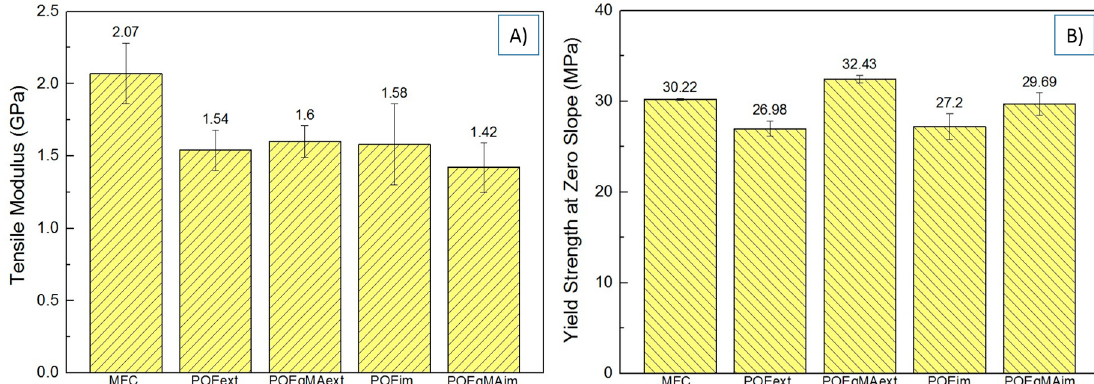
Figure 5. Tensile properties of MFC composites ( A ) Tensile modulus; ( B ) Yield strength at zero slope. Table 4. Strain at break of the